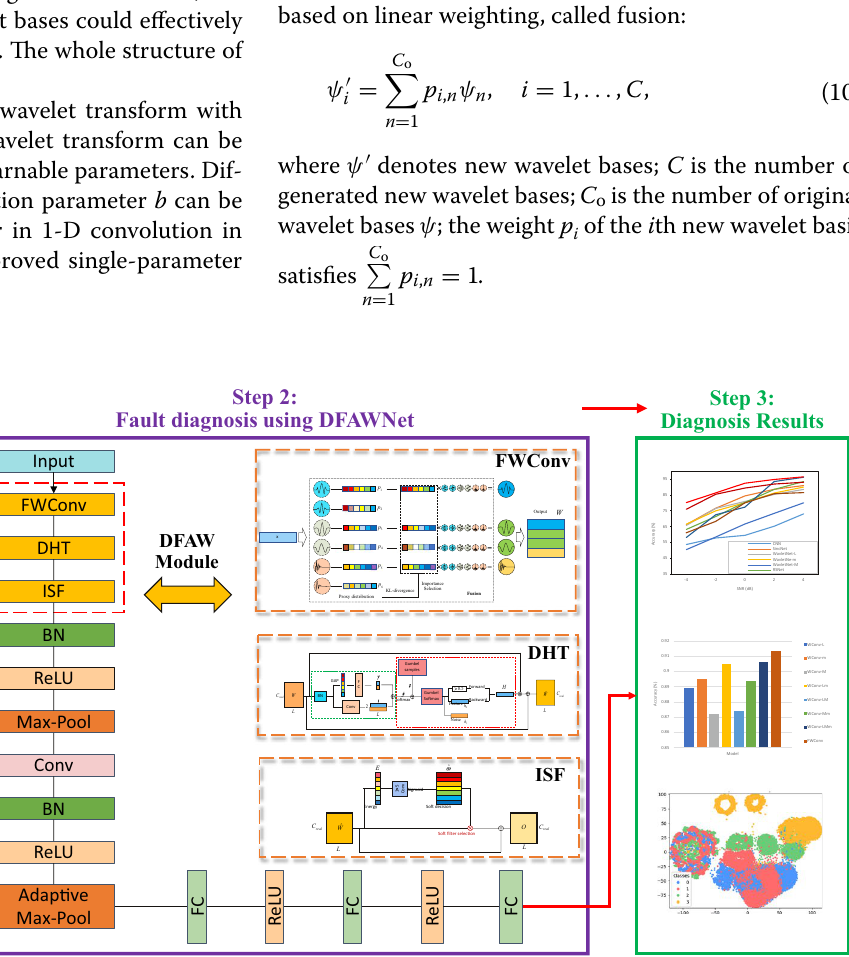
Figure 5 Schematic of DFAWNet for fault